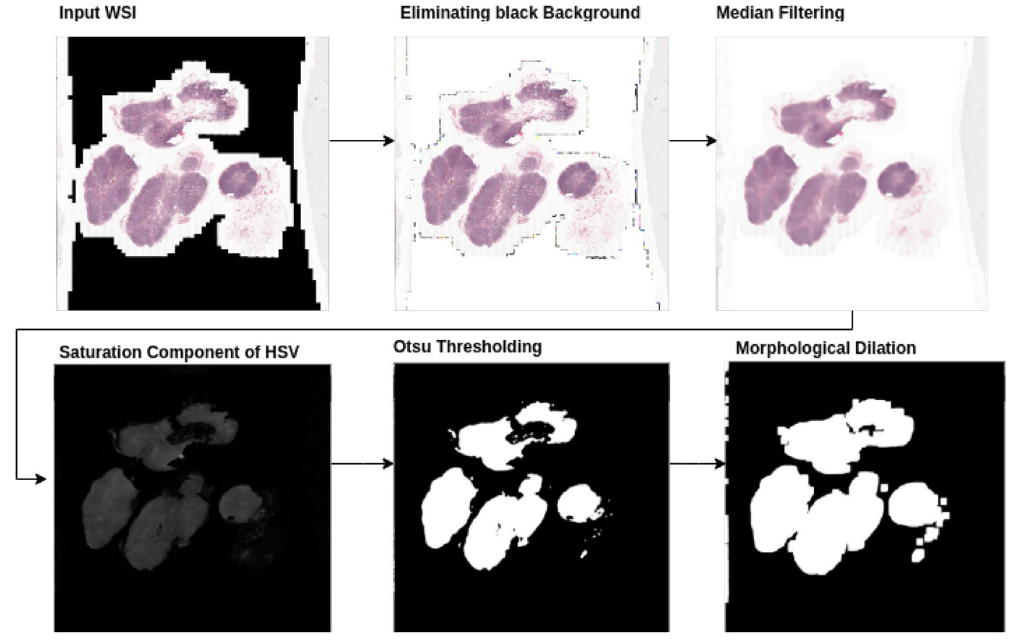
Figure 3. An illustration of the intermediate stages in the process of tissue mask generation from a WSI image in CAMELYON17 dataset. Drawn using draw.io